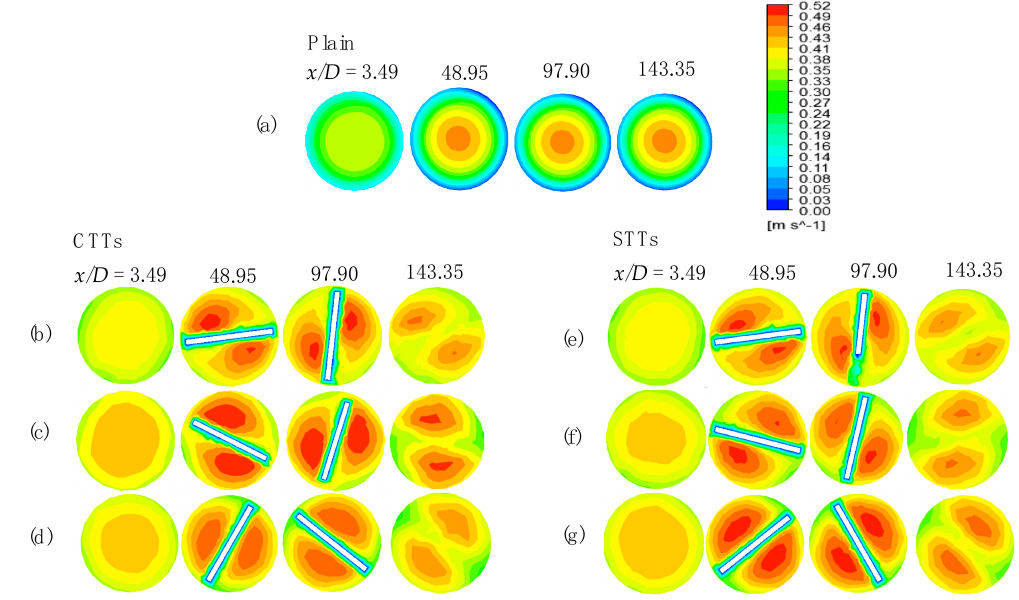
Figure 8. Contour plots of velocity in inner tube at axial locations x / D of 3.49, 48.95, 97.90, and 143.35 at Re = 14,100 for (a) PT, (b) y / W = 2.7 CTT, (c) y / W = 4.5 CTT, (d) y / W = 6.5 CTT, (e) y / W = 2.7 STT, (f) y / W = 4.5 STT, and (g) y / W = 6.5 STT.